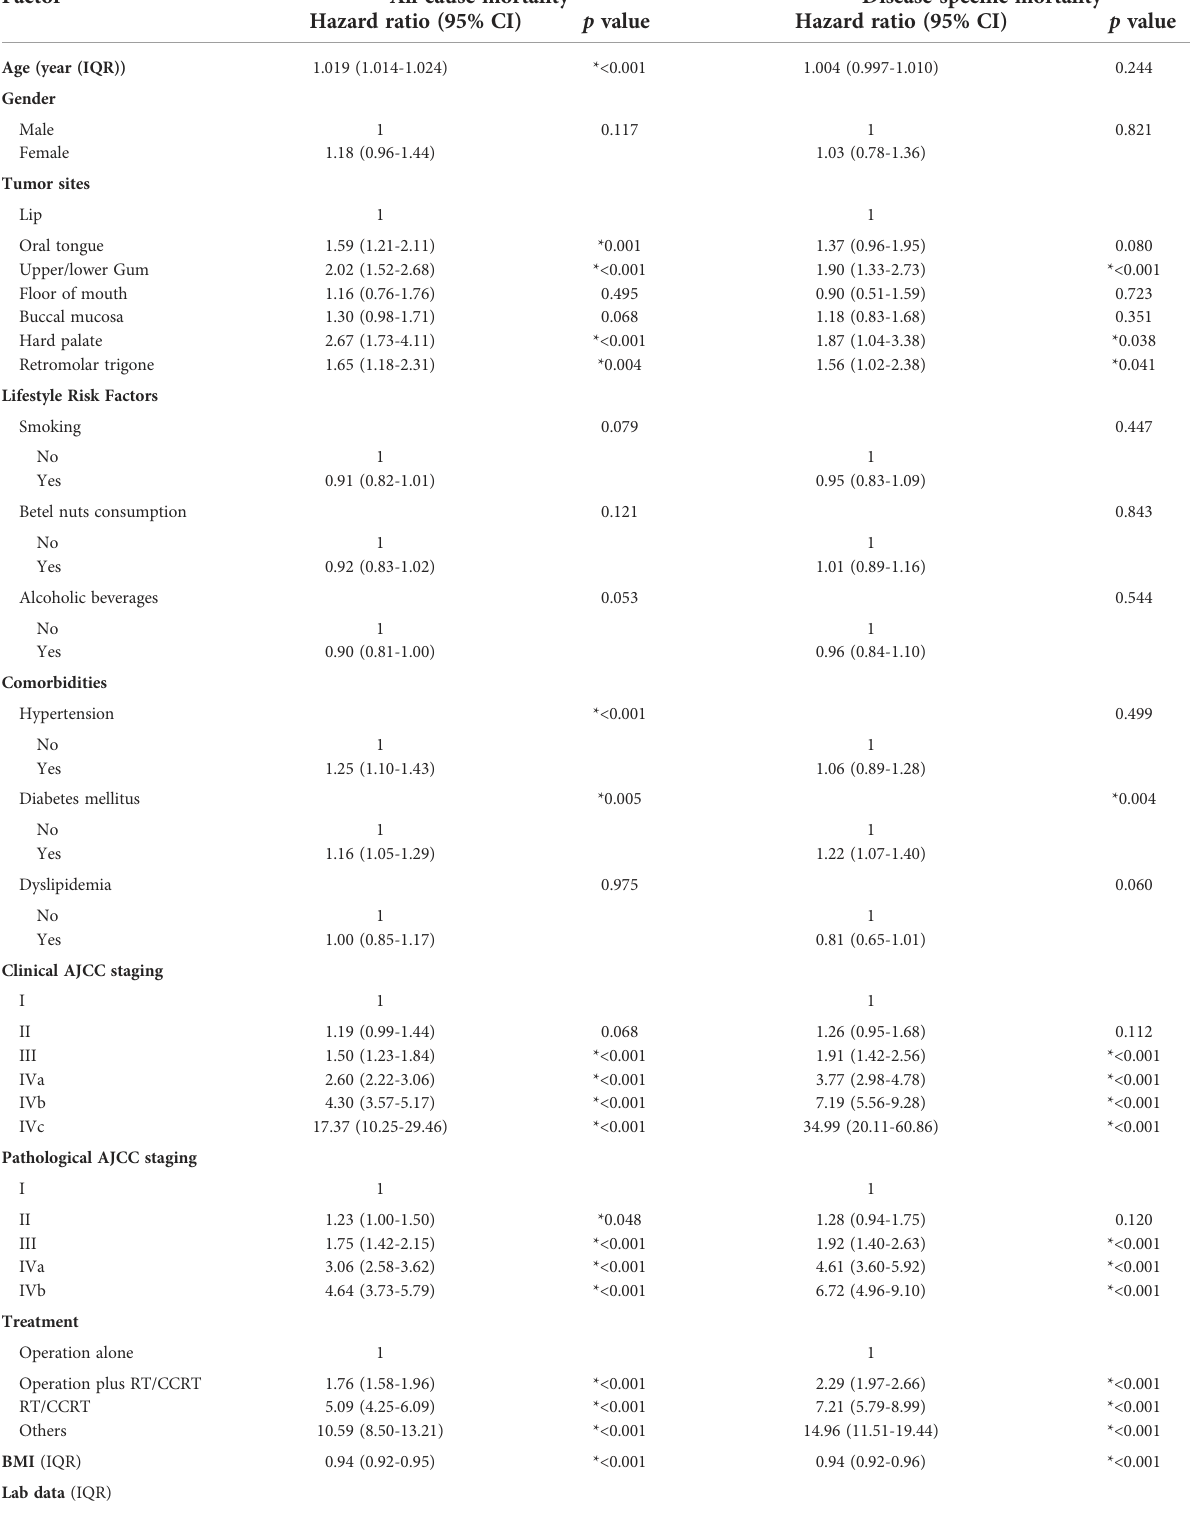
TABLE 2 Univariate analyses of prognostic factors for all-cause mortality and disease-speci fi c mortality in patients with oral